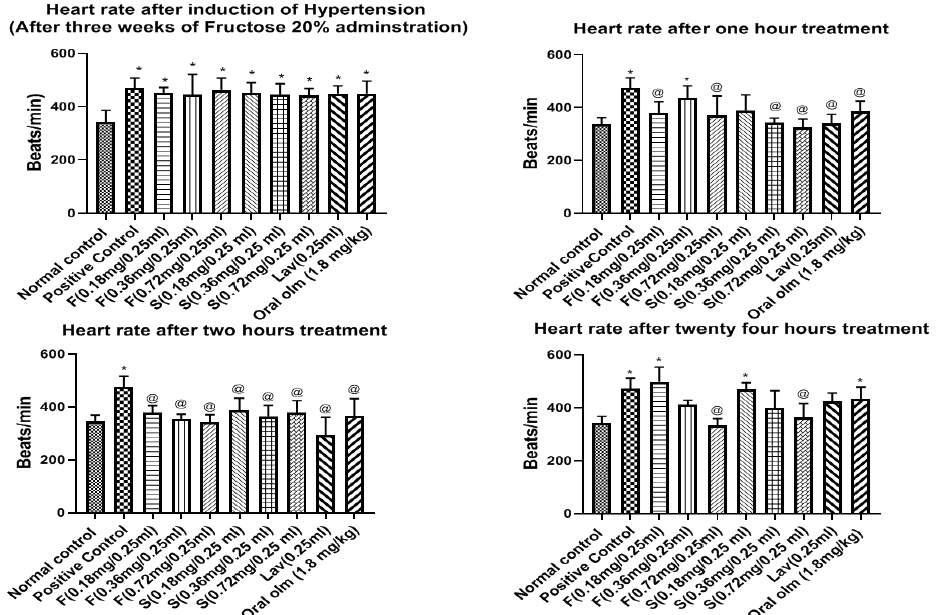
Figure 10. Heart rate of the ten examined rats’ groups after three weeks of hypertension induction, and after 1, 2, and 24 h of treatment. Presented data are the mean ± SD (n = 3). Abbreviations: F = Transdermal oleogel formulation, S = Transdermal standard gel, Lav = Transdermal Lavender oil (0.25 mL), Oral Olm = Oral Olmesartan Medoxomil market tablet (Angiosartan ® Tablets). * Signi fi - cantly di ff erent from the normal control group at respective time interval ( p < 0.05). @ Signi fi cantly di ff erent from positive group at respective time interval ( p < 0.05).